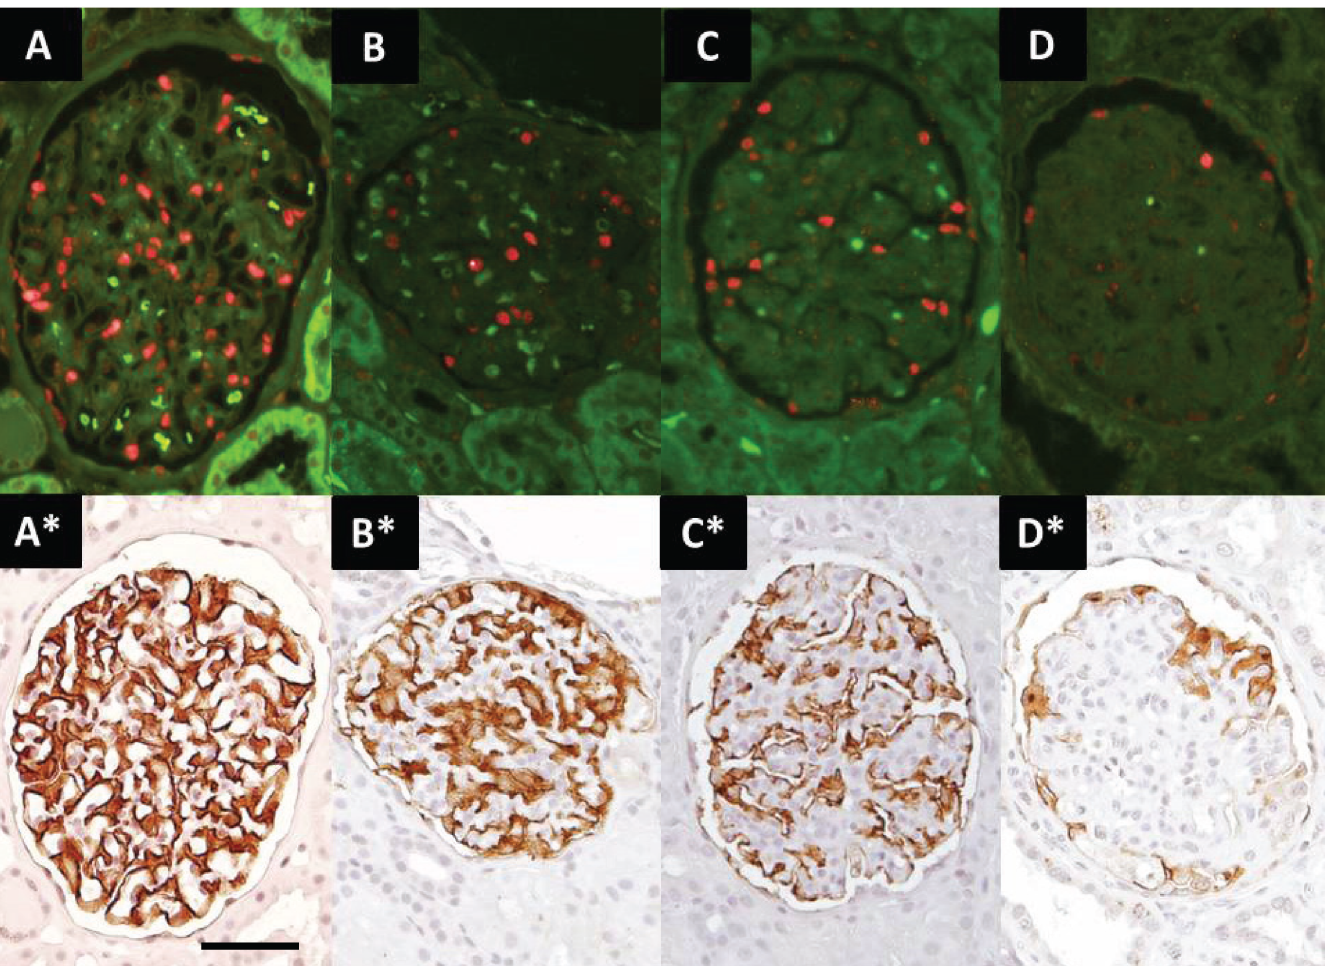
Fig 1. Identification of podocyte nuclei and cells in ASC biopsies. Upper panels show podocyte nuclei (red) identified by TLE4 immunofluoresce. Lower panels show Glepp1 immunoperoxidase (brown) in the same sections. Panels A and A * shows a normal glomerulus. Panels B to D and B * to D * show glomeruli with progressively reduced numbers of podocytes and Glepp1 peroxidase positive area (as a % of the glomerular area) representing progressive glomerular injury associated with AS. Parietal podocytes are excluded from analysis by delineating the area of interest using software so that the podocyte nuclear count and Glepp1 area quantitation is for the tuft area only. Magnification is the same for all panels where the bar shown represents